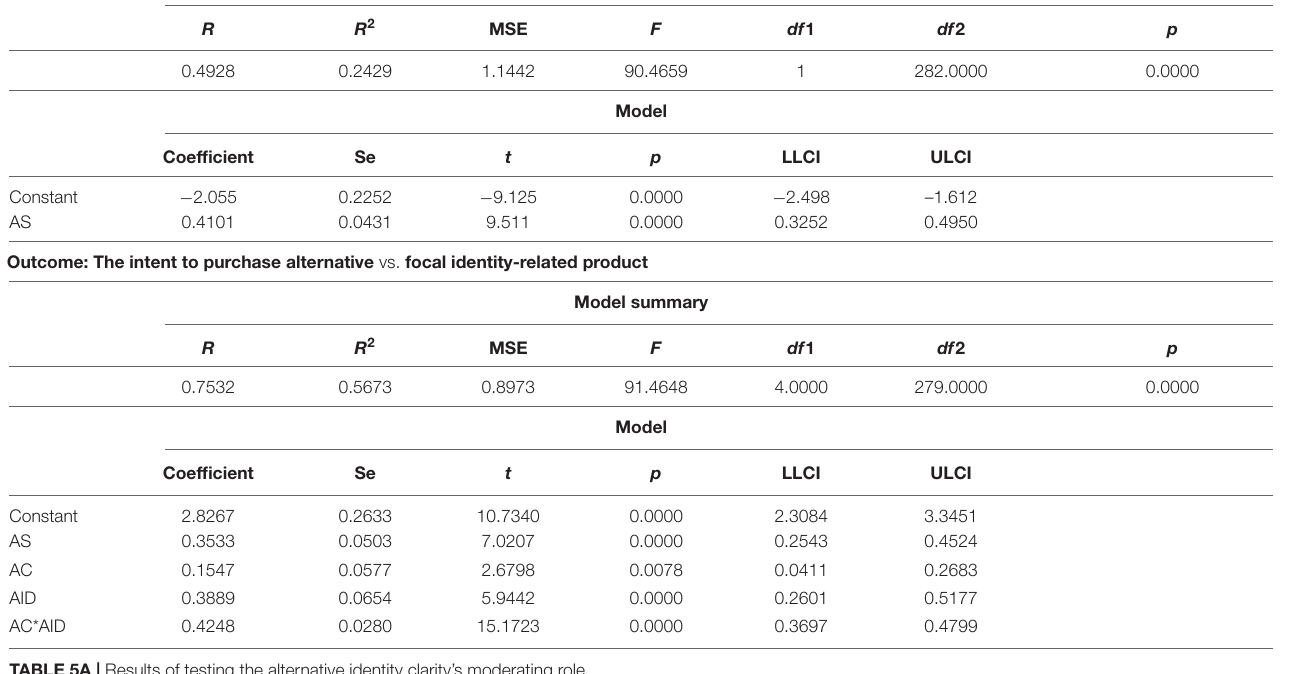
TABLE 5A | Results of testing the alternative identity clarity’s moderating role.